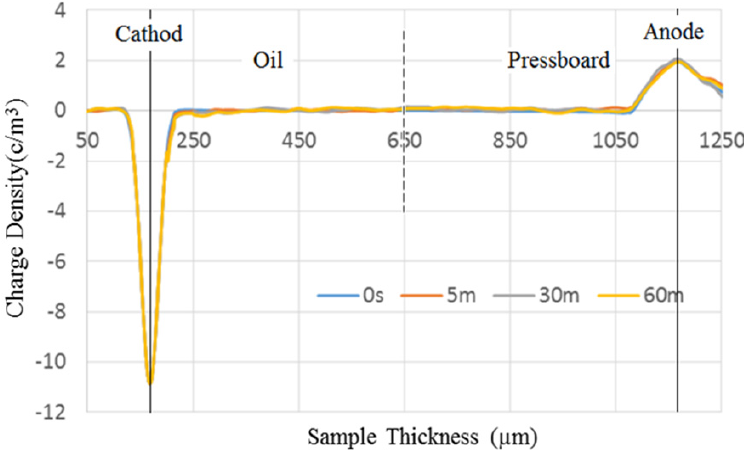
Figure 26. Volt ‐ on results of space charge in fresh oil combined with impregnated pressboard insulation system under 9.6 kV/mm AC field at 81° [53].